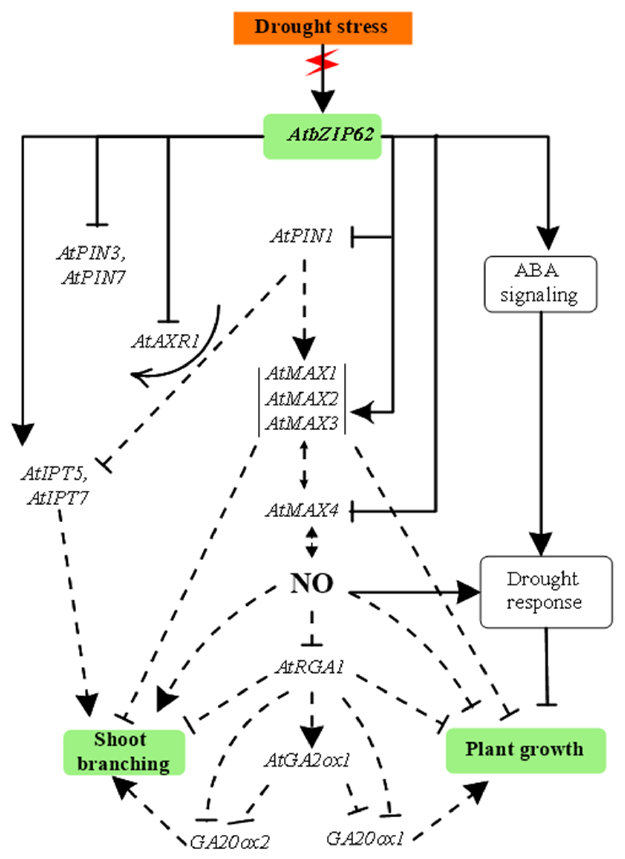
Figure 3. Signaling model involving AtbZIP62 transcription factor (TF) and more axillary branching (MAX), PIN-FORMED, gibberellic acid (GA), and isopentenyl transferase (IPT) encoded genes under drought stress. Upon drought stress induction, a variety of signals transduction and hormonal pathways are activated, followed by the induction of an array of drought-responsive genes, including transcription factors, such as AtbZIP62 which interact with other proteins or DNA to regulate the expression of stress inducible genes. As part of the drought response mechanism, plants activate ABA signaling components, which interact with other signaling pathways and specific genes in order to provide an appropriate response towards stress tolerance. Consequently, the regular plant growth-related metabolism is reduced. In the proposed signaling model, AtbZIP62 TF is shown to differentially regulate the transcripts accumulation of AtMAX1 , AtMAX2 , AtMAX3 , AtMAX4 (SL), AtPIN1 , AtPIN3 , AtPIN7 (auxin carriers), AtGA2ox1 , AtGA20ox1 , AtGA20ox1 , and AtRGA1 , AtIPT5, and AtIPT7 (Cytokinin) genes. Arrows with continuous lines indicate positive regulation (of gene expression or induction of plant growth/shoot branching). Continuous lines with a perpendicular bar or an arrow suggest a negative regulation/inhibition or positive regulation/induction (of gene expression or plant growth/shoot branching) by our studies (current and previous). Dotted lines with a perpendicular bar or an arrow suggest a negative regulation/inhibition or positive regula- tion/induction (of gene expression or plant growth/shoot branching) by previous evidence by other research groups. NO, nitric